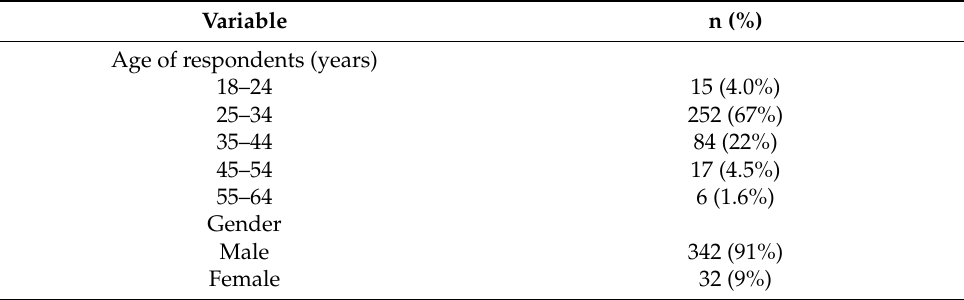
Table 1. General characteristics of